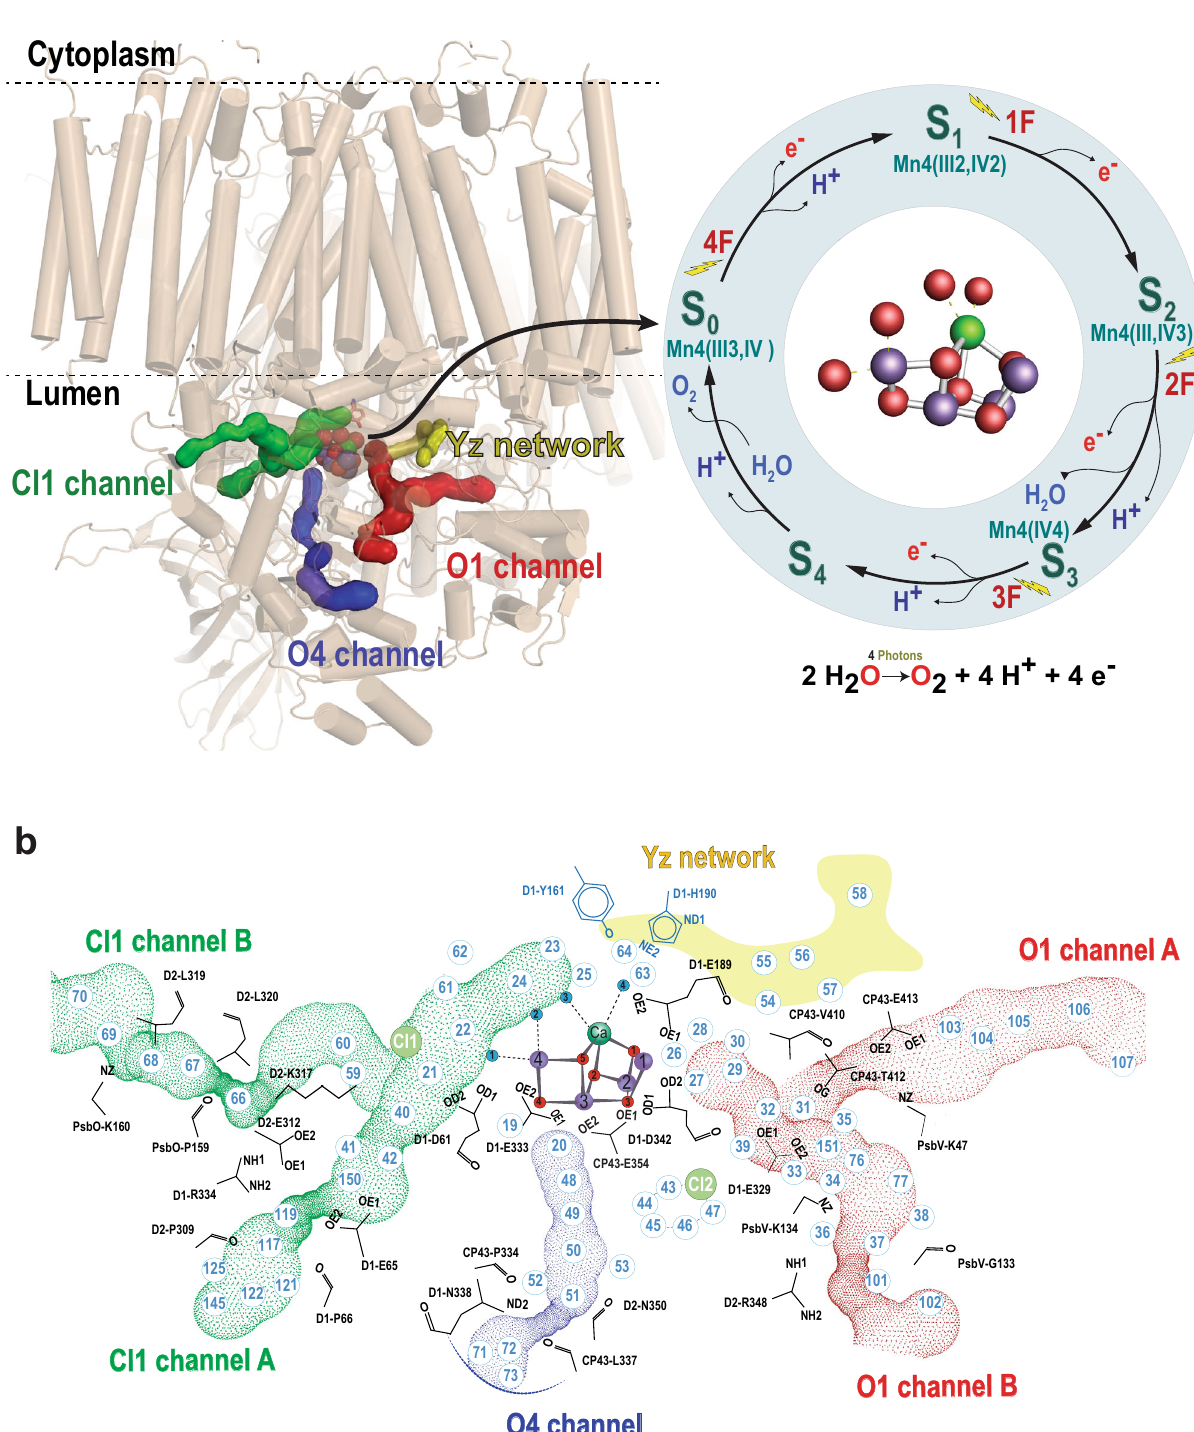
Fig. 1 An overview of Photosystem II and the main water channels and networks from the OEC to the lumenal side. a (Left) The structure of PS II showing the membrane-embedded helices and the extrinsic subunits in beige. The OEC and the water channels, in addition to the Yz network, are shown in color. The Kok cycle of the water oxidation reaction that is triggered by the absorption of photons is shown on the right and highlighted with a blue circle. b A detailed view of the water channels showing the waters within each channel (O1 Channel red dotted, O4 Channel blue dotted, and Cl1 Channel green dotted). The region highlighted with solid yellow represents the Yz network. Residues involved in forming bottlenecks in the channels are shown in